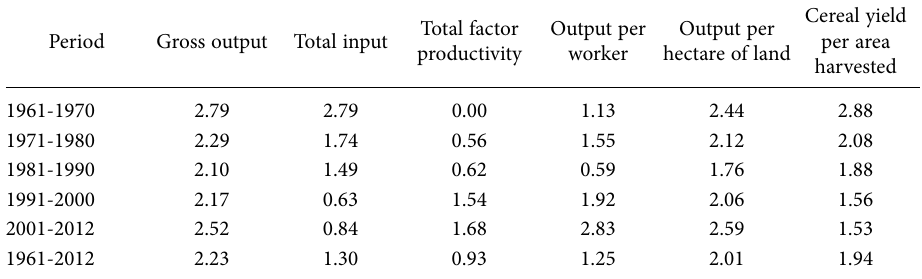
Table 3. Productivity Indicators for World Agriculture (average annual growth rate in percent). Period Gross output Total input